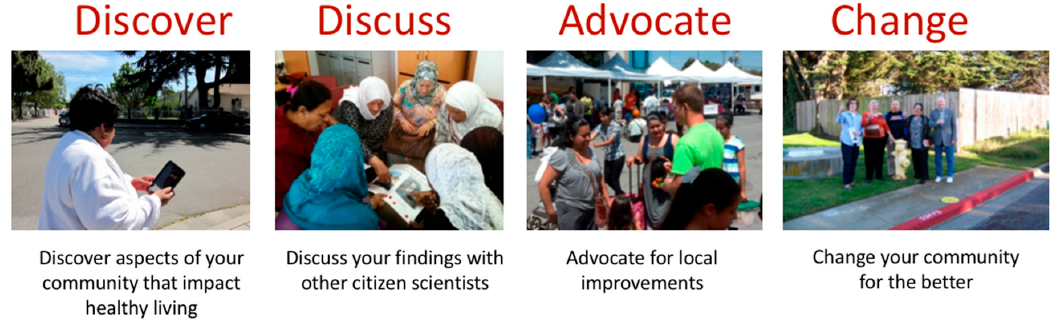
Figure 1. The 4 step Our Voice citizen science model [24]. © Stanford University. All rights reserved.